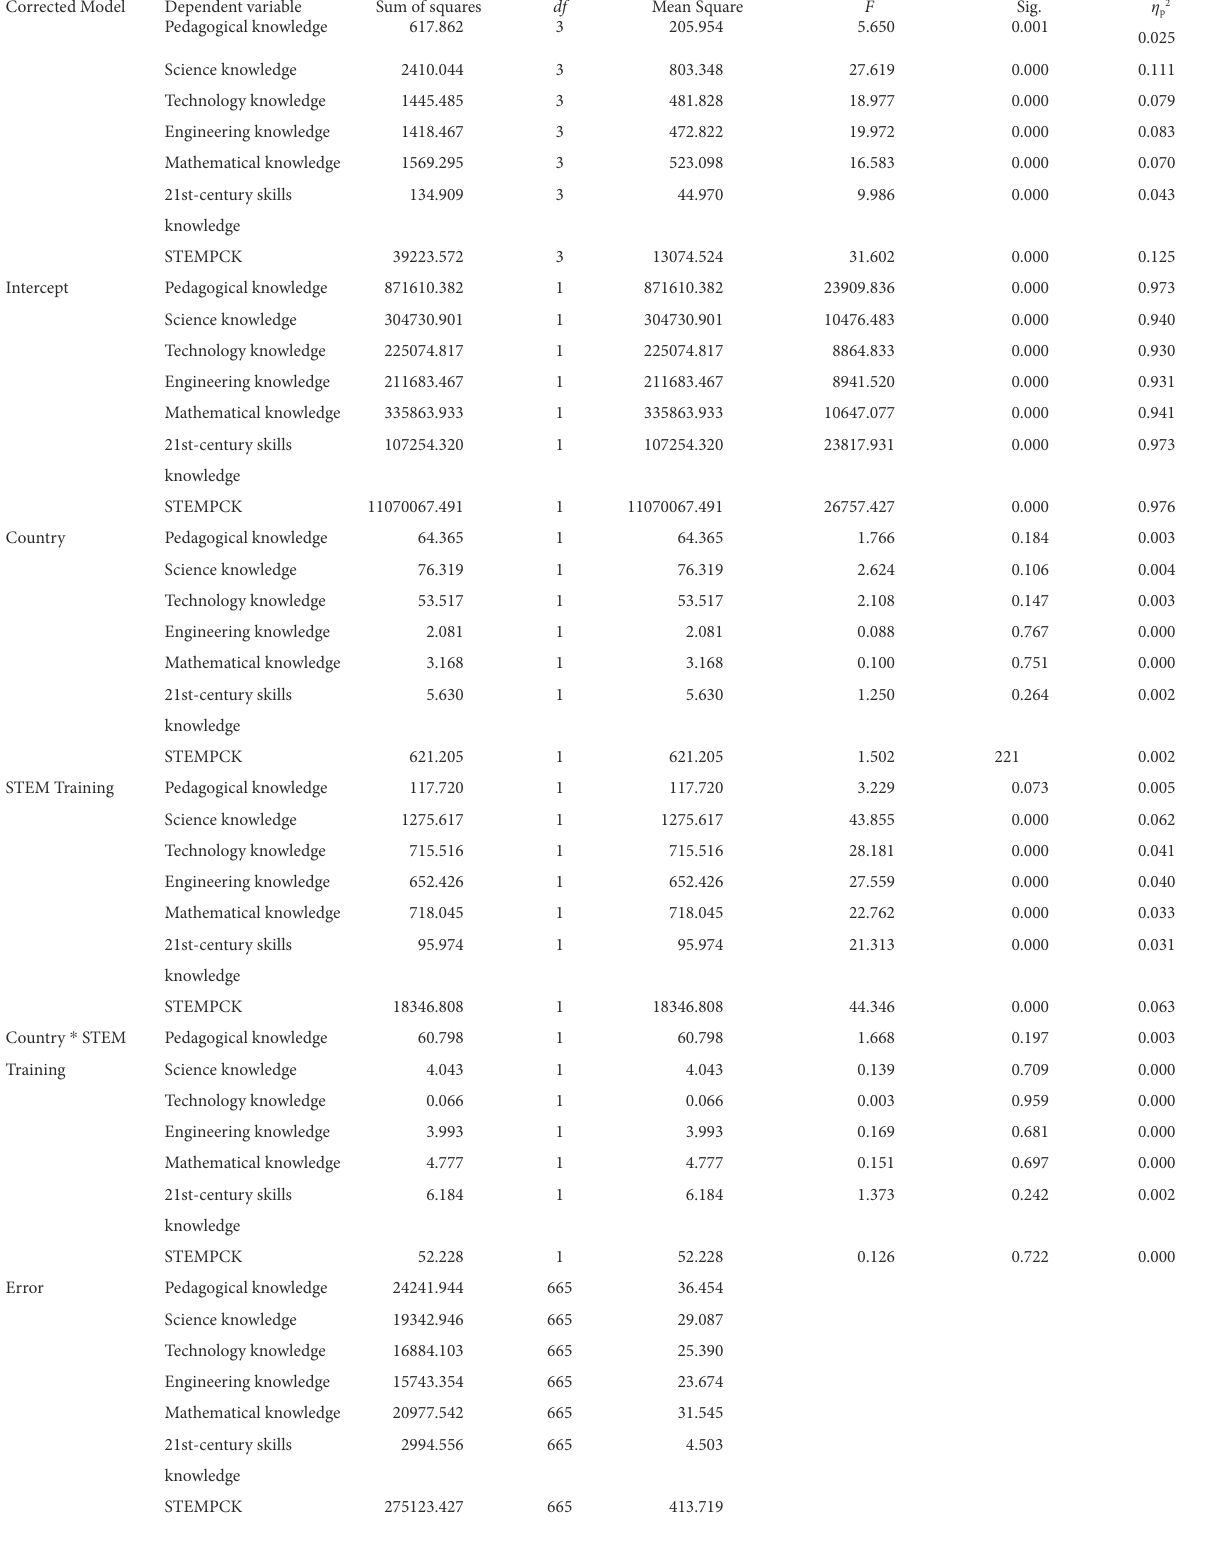
TABLE 6 Multidirectional analysis of variance values and pairwise